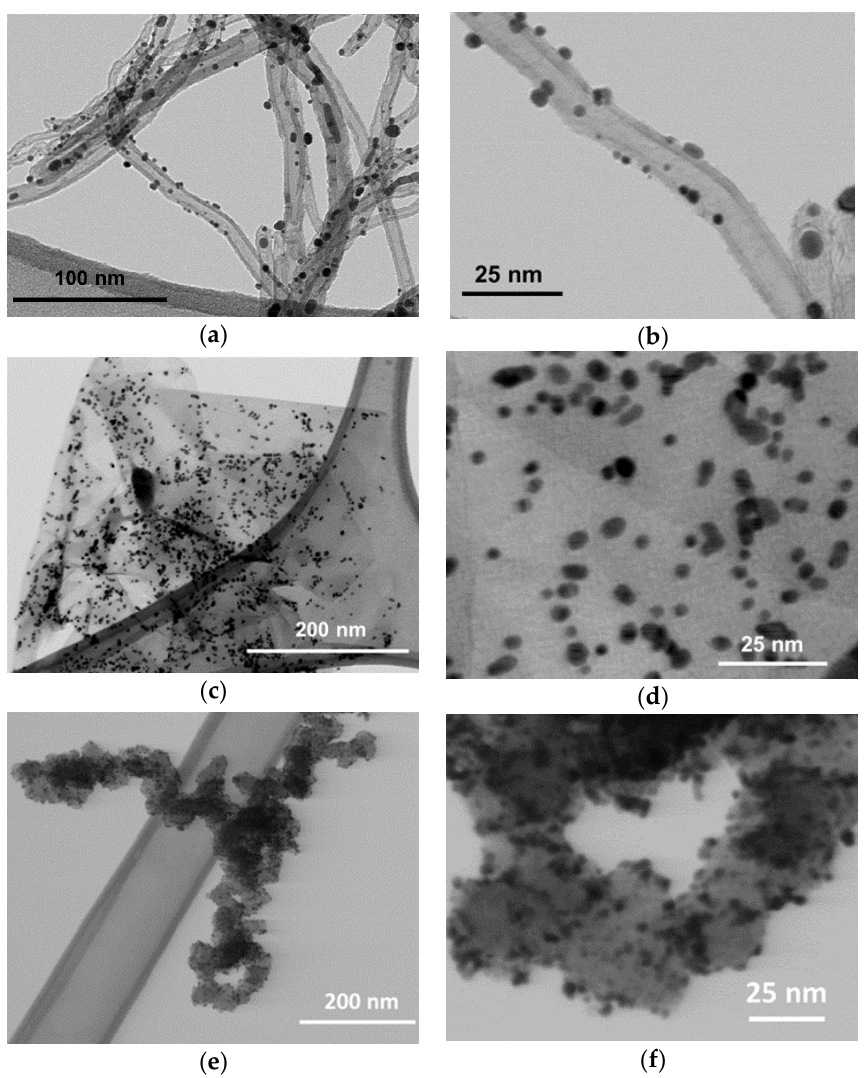
Figure 1. STEM images of Pt catalyst ( a , b ) deposit on MWCNTs by thermal treatment, ( c , d ) Pt deposit on FGLs by chemical reduction, ( e , f ) Pt on carbon blacks TEC10V50E. Table 1. Particle size distribution for electrocatalysts Pt/C, Pt/MWCNTs and Pt/FGLs determined by statistical STEM study.